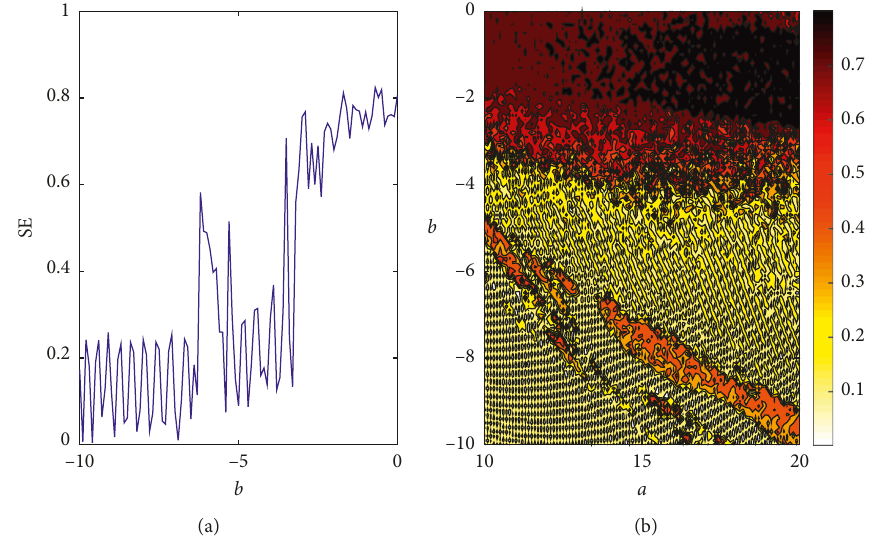
Figure 9: The complexity of SE of system (2): (a) SE versus b when a � 11 and (b) in the a − b